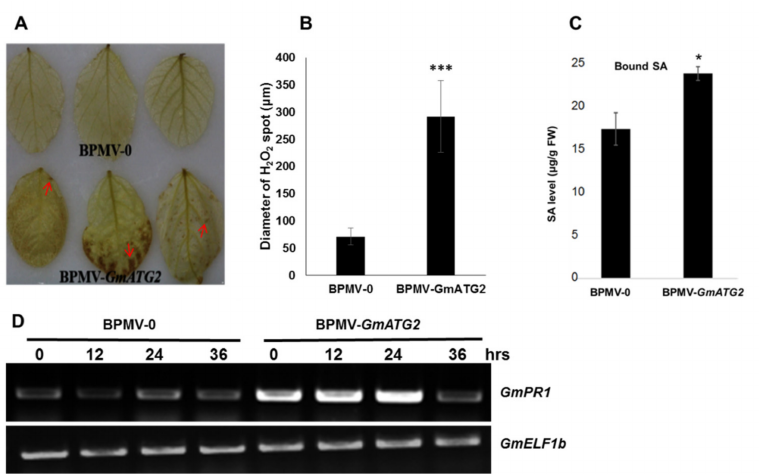
Figure 4. Defense responses are activated in GmATG2 -silenced plants under dark conditions. ( A ) H 2 O 2 level enhanced significantly in the BPMV- GmATG2 plants relative to BPMV-0 plants treated in the dark for 3–4 days. The red arrows pointed to the sites of the ROS accumulation; ( B ) the diameters of H 2 O 2 staining spots in A were measured under a dissecting microscopy. The data are shown as means ± SD. *** p < 0.001, Student’s t -test; ( C ) The bound SA level enhanced significantly in the BPMV- GmATG2 plants relative to BPMV-0 plants. * p < 0.05, Student’s t -test; ( D ) Expression of PR1 gene was induced to a much higher level in GmATG2 -silenced plants than in vector control plants. RNA samples were extracted from the indicated plants at 0 min, 12 h, 24 h and 36 h post dark treatment; GmELF1b was used as the internal reference gene. These experiments were repeated at least twice with a similar result. At least 3 plants were used in each